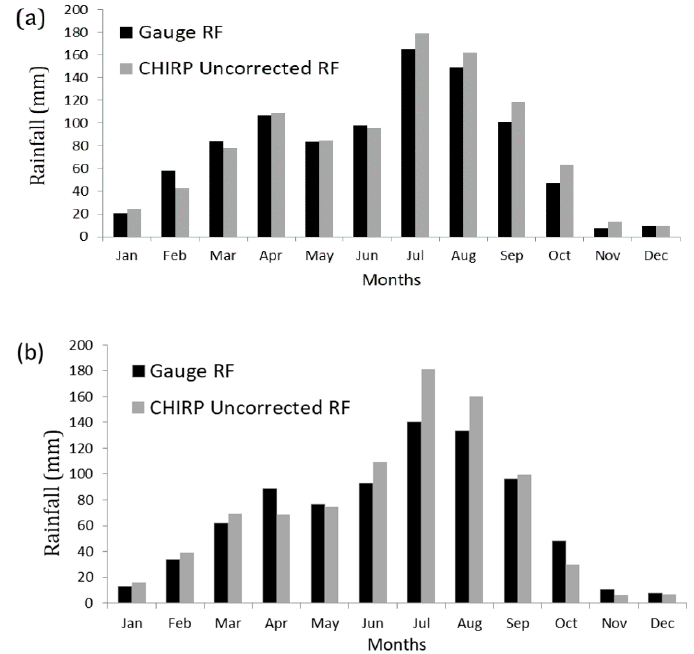
Figure 5. Comparison of mean monthly rainfall (1985–2000) for the CHIRP satellite and the rain gauge time series from an ensemble of 14 rain gauges and grid cells; ( a ) Meki catchment ( b ) Katar catchment.